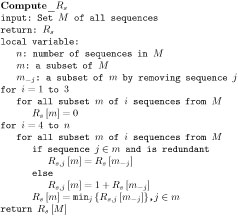
Bafna and Bansal's algorithm for Rs.